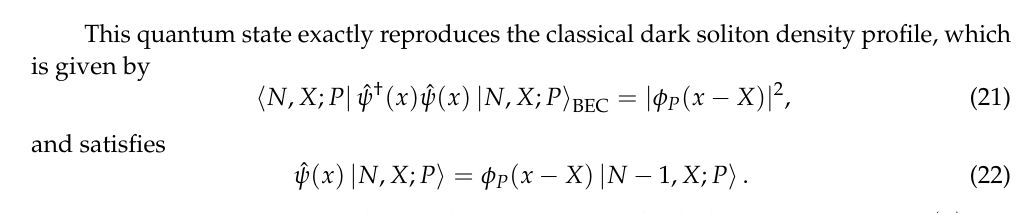
Figure 1. The overlap | C { I represents an eigenstate { I j } with the momentum ∑ N implies a large overlap. The eigenstate with the lowest energy for a given momentum P corresponds to an yrast state | N , P (cid:105)